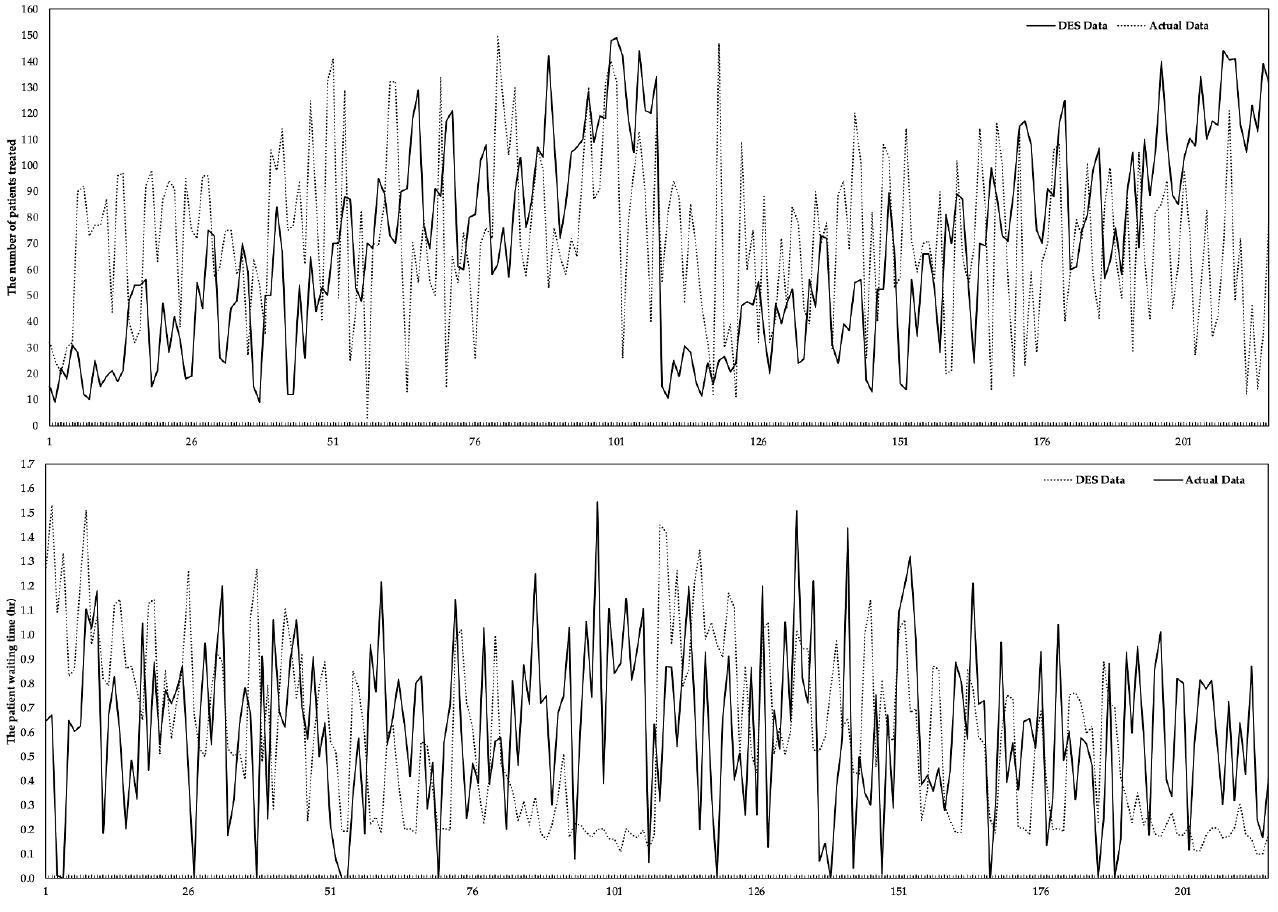
Figure 3. Verifying the output of the DES model.